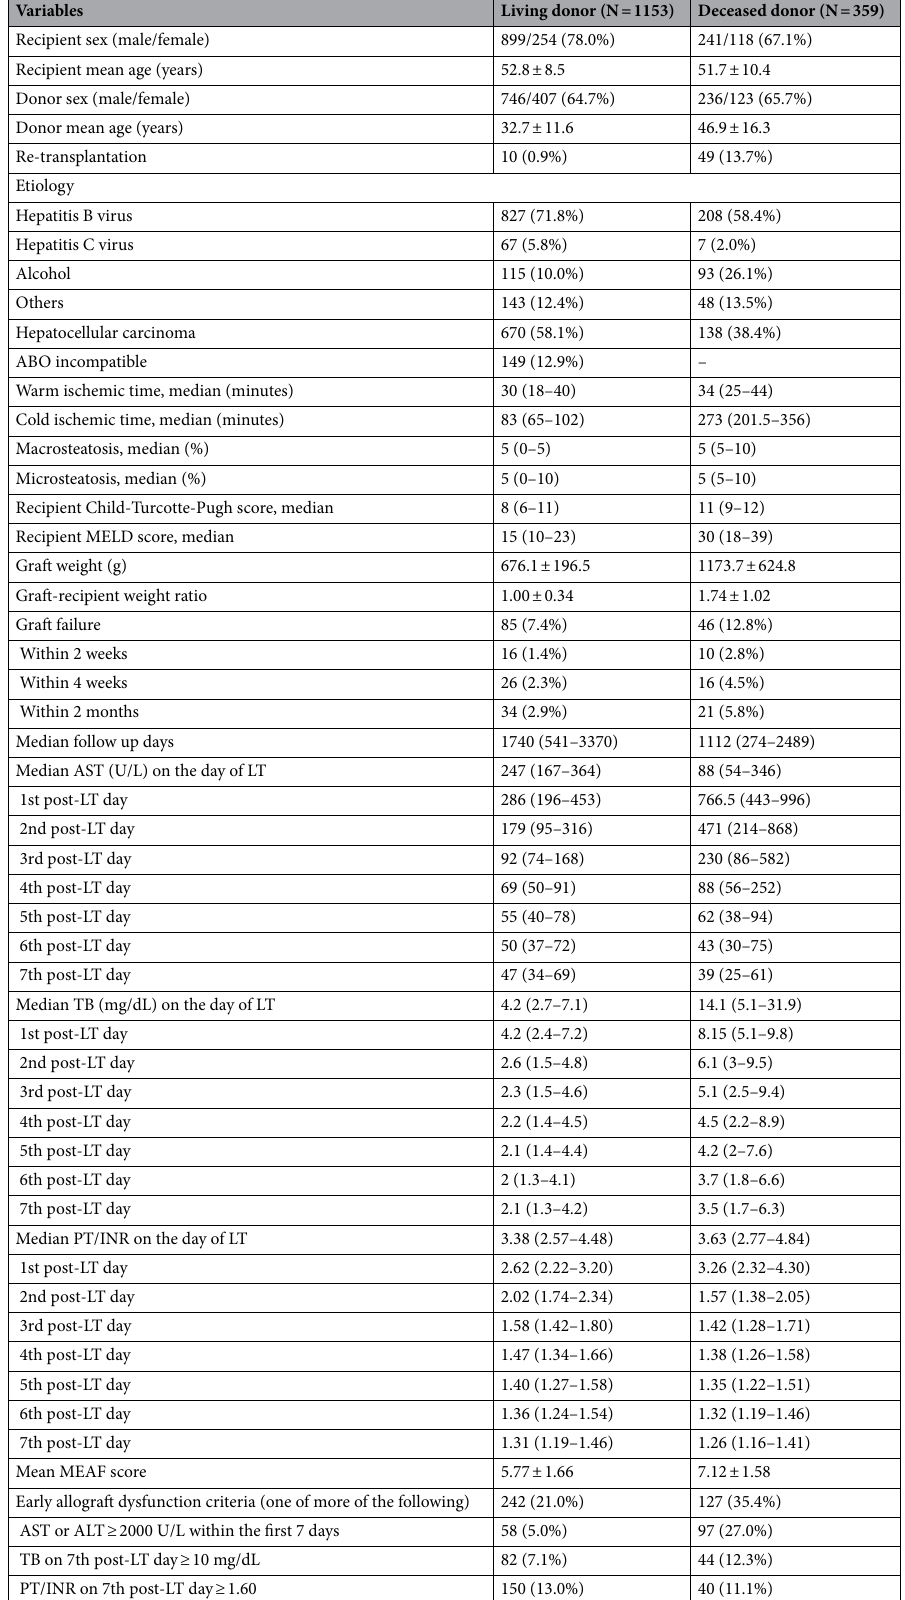
Table 1. Baseline characteristics and postoperative graft failures of adult liver transplantation patients. MEAF model for early allograft function, INR international normalized ratio, TB total bilirubin, AST aspartate aminotransferase, ALT alanine